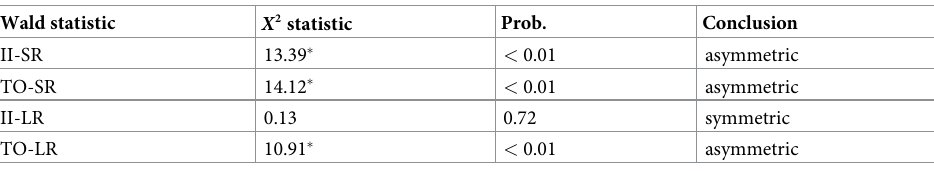
Table 7. Test for